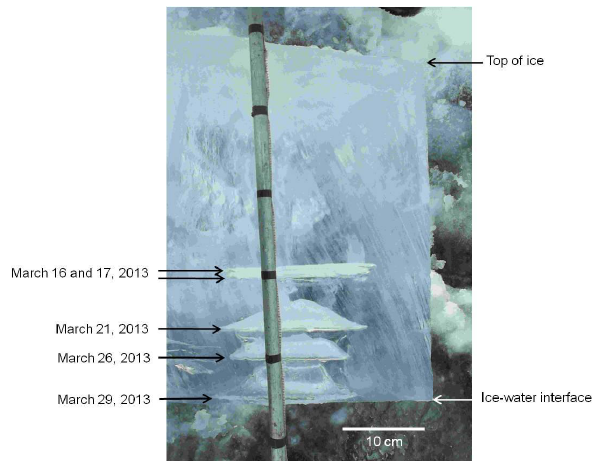
Figure 6: Results of ebullition simulation in a controlled lake-ice environment. Flat gas pockets sealed in the ice formed from ebullition events on March 16 and March 17, 2013. Subsequently, the topology of the lower ice surface warped into concave, dome-shaped “tents” due to ice growing at a relatively slower rate directly beneath the stack of gas pockets. Ebullition events on March 21 and 26 displaced lake water in the tents and filled the tents with gas. No further ebullition events occurred, yet the bottom surface of the lake ice sheet was rough, with a 4-cm indentation filled with lake water when this ice block was removed from the lake on March 29, 2013.